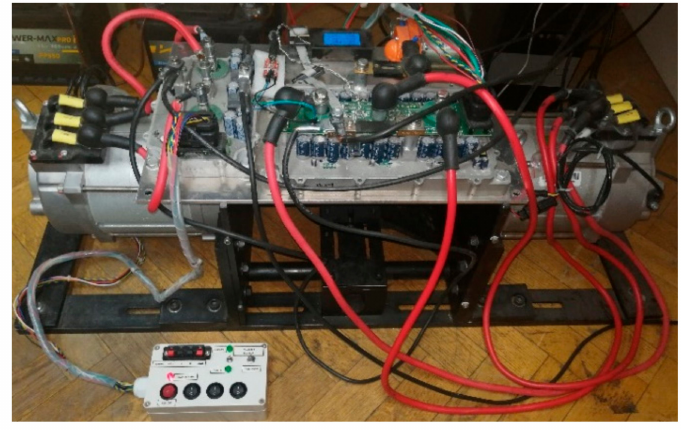
Figure 4. Coupling of the motor-generator group with 48 V DC power supply (4 series connected 12 V batteries).